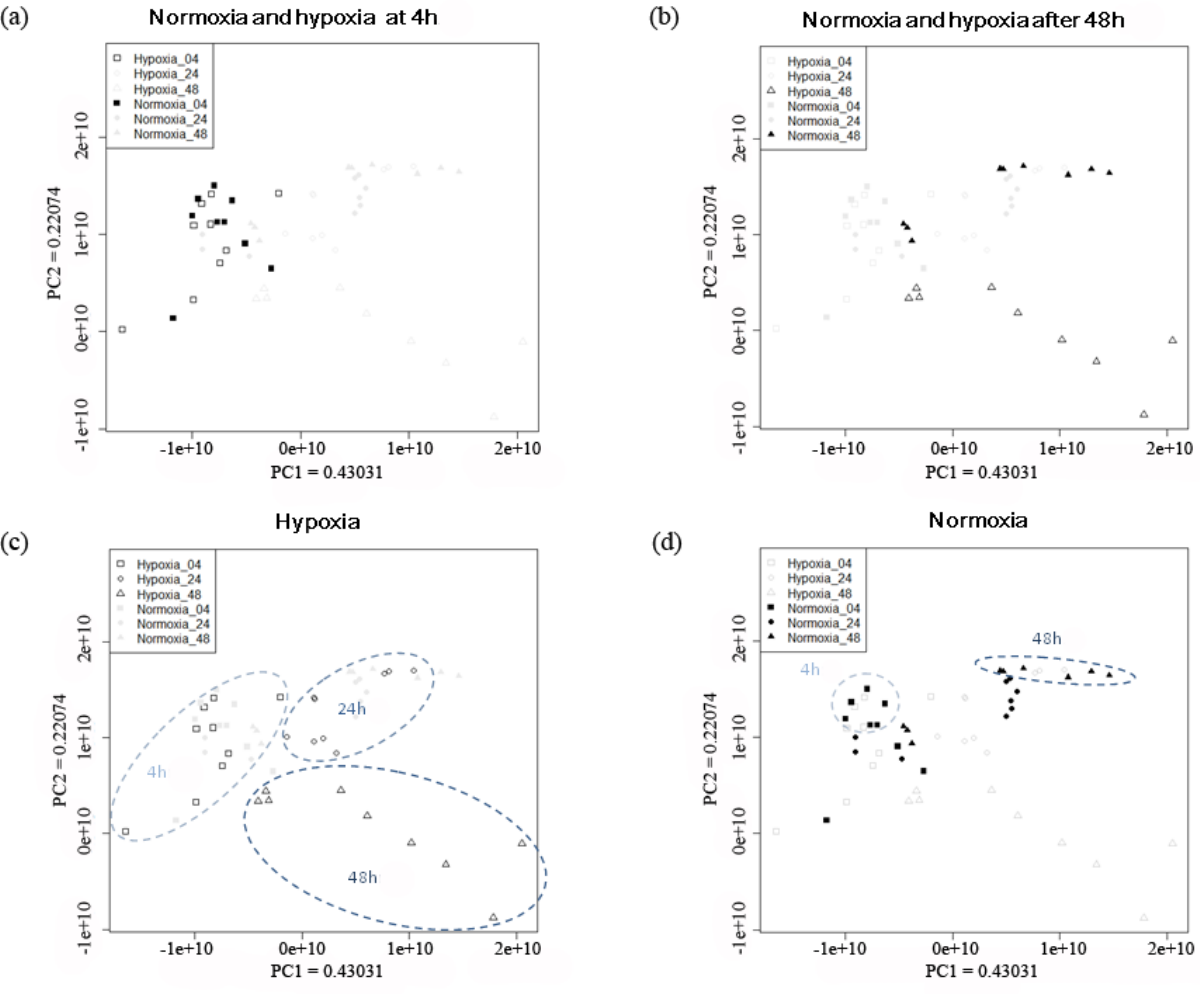
Figure 2. PCA scores plots of MDA-MB-231 breast cancer cells during extended periods of hypoxia and normoxia. ( a ) normoxia and hypoxia group with 4 h treatment was highlighted. ( b ) normoxia and hypoxia group after 48 h treatment was highlighted ( c ) hypoxia group at different time points was highlighted. ( d ) normoxia group at different time points was highlighted. The values of principal component 1 (PC1) and principal component 2 (PC2) on the axes indicated the proportion of variance explained by each of the principle component. Normoxia with 4 h treatment ( ■ , n = 9); 24 h treatment ( ● , n = 9); 48 h treatment ( ▲ , n = 9). Hypoxia with 4 h treatment ( □ , n = 9); 24 h treatment ( ○ , n = 9); after 48 h treatment ( △ , n =